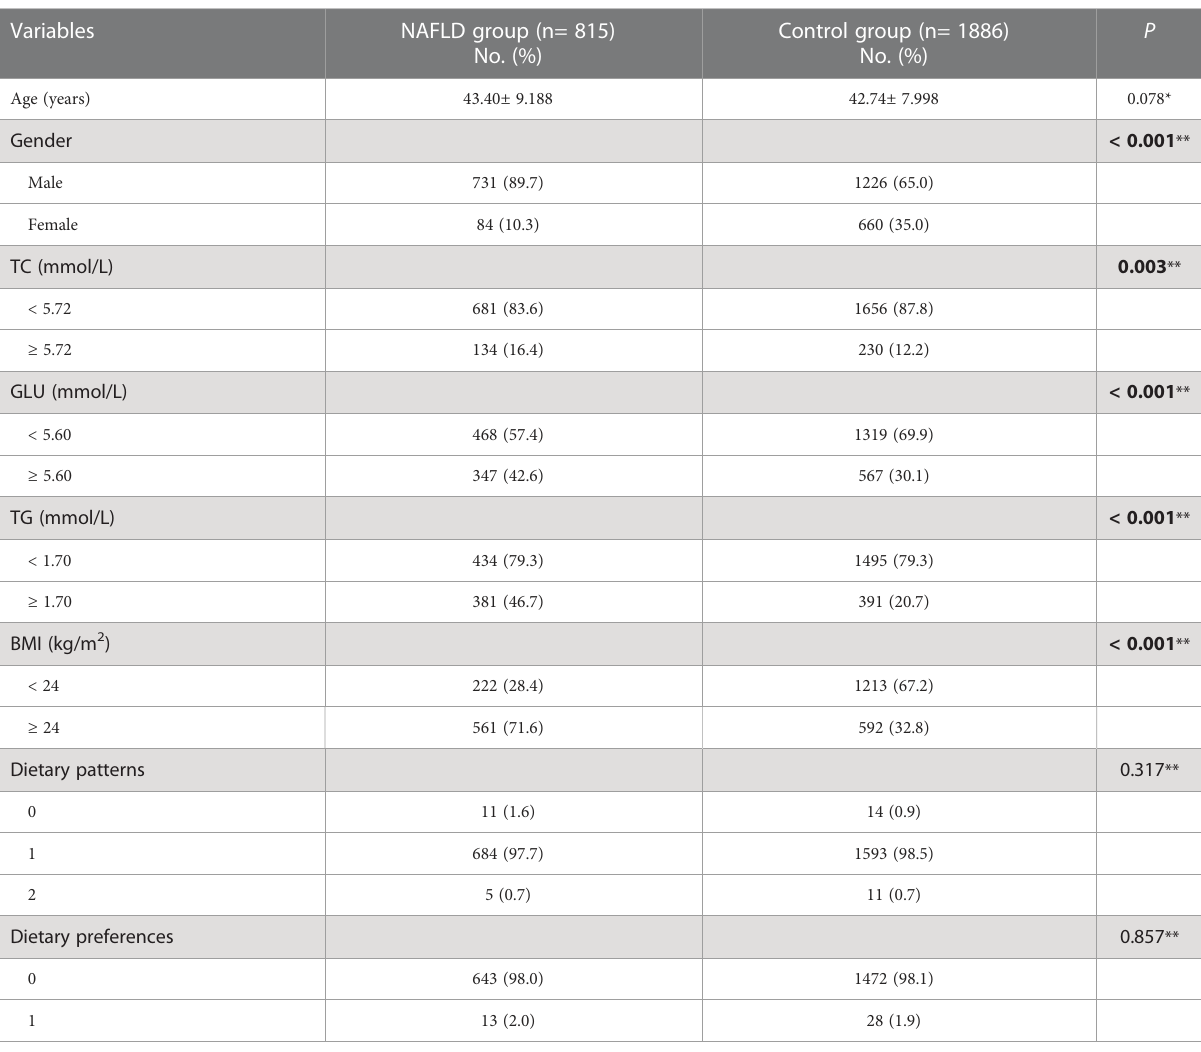
TABLE 1 Comparison of demographic and clinical data between the NAFLD and control groups.